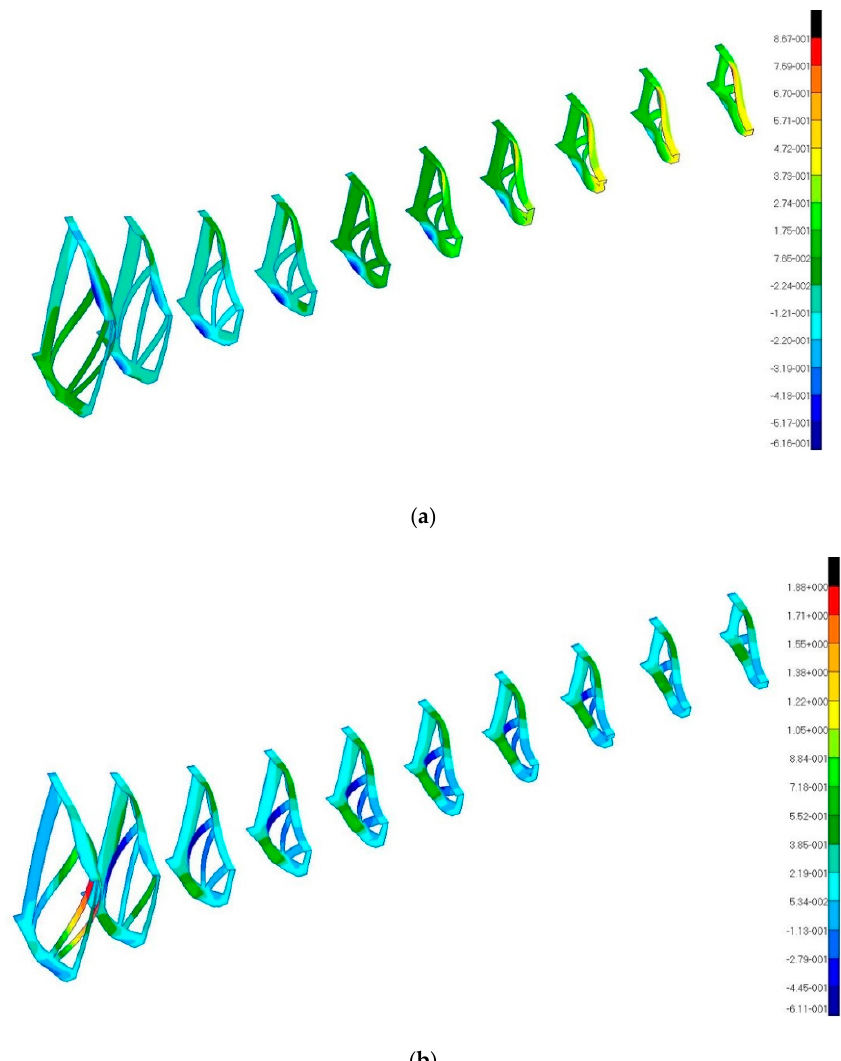
Figure 21. The rib deflection on the edgewise maximum load: ( a ) x-direction fringe and ( b ) z-direction fringe.